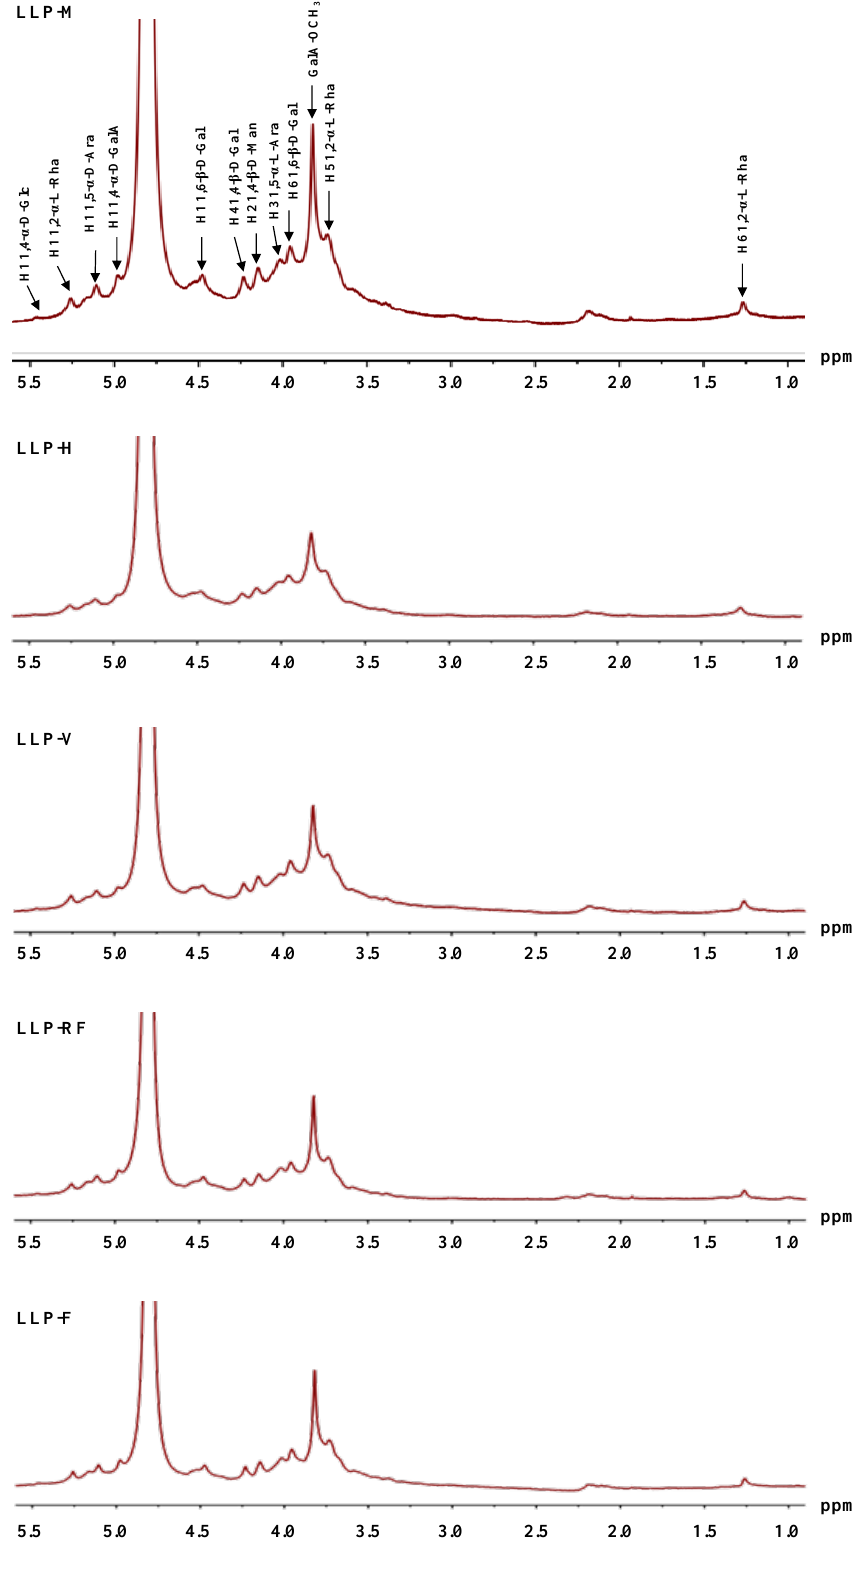
Figure 3. 1 H NMR spectra of LLPs.